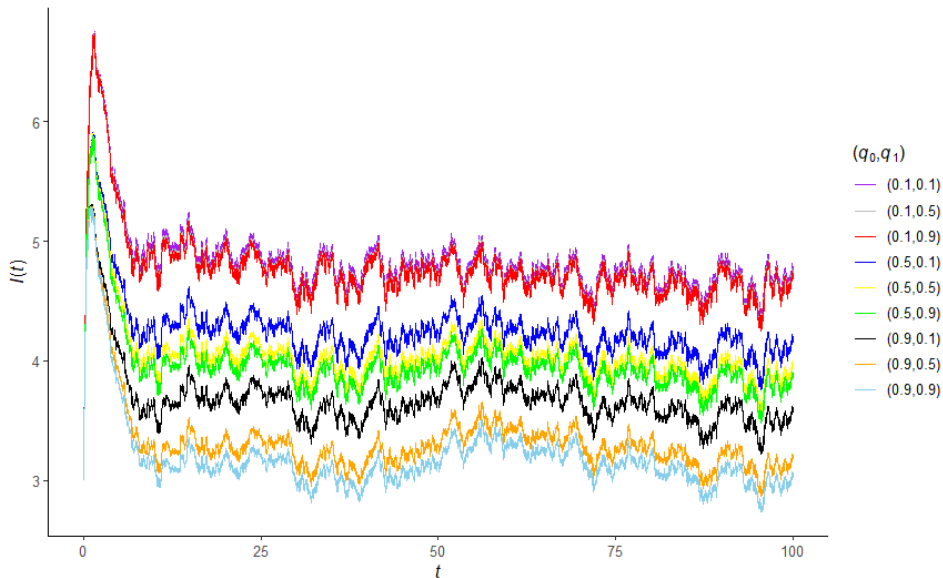
Figure 6. The simulated numbers of total infected individuals under the different ( q 0 , q 1 ) combina- tions.